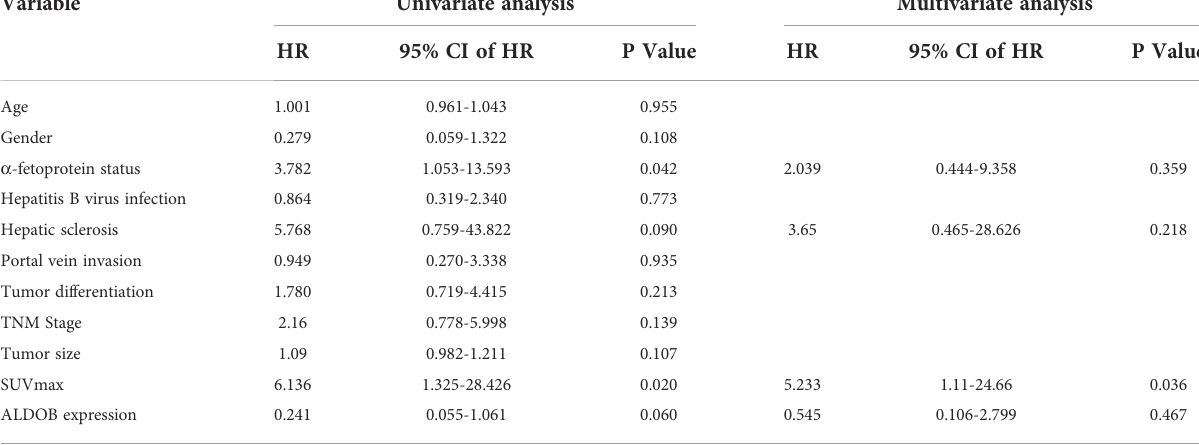
TABLE 2 Univariate and multivariate Cox regression analysis of overall survival in patients with HCC.